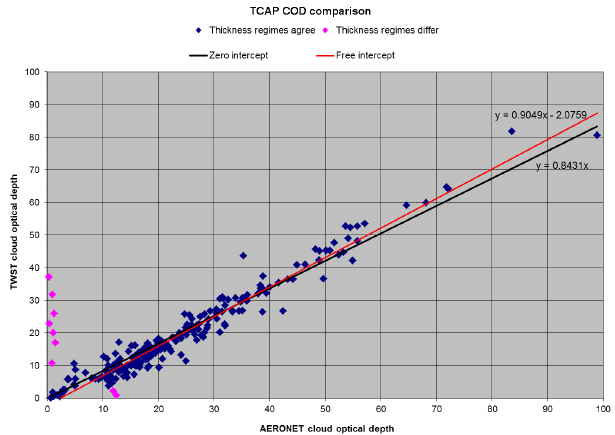
Figure 16. Comparison of TWST and AERONET cloud-mode cloud optical